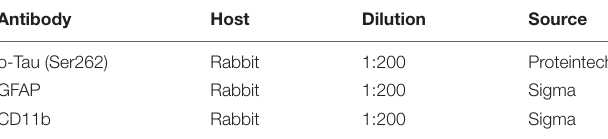
TABLE 2 | The following primary antibodies were used for